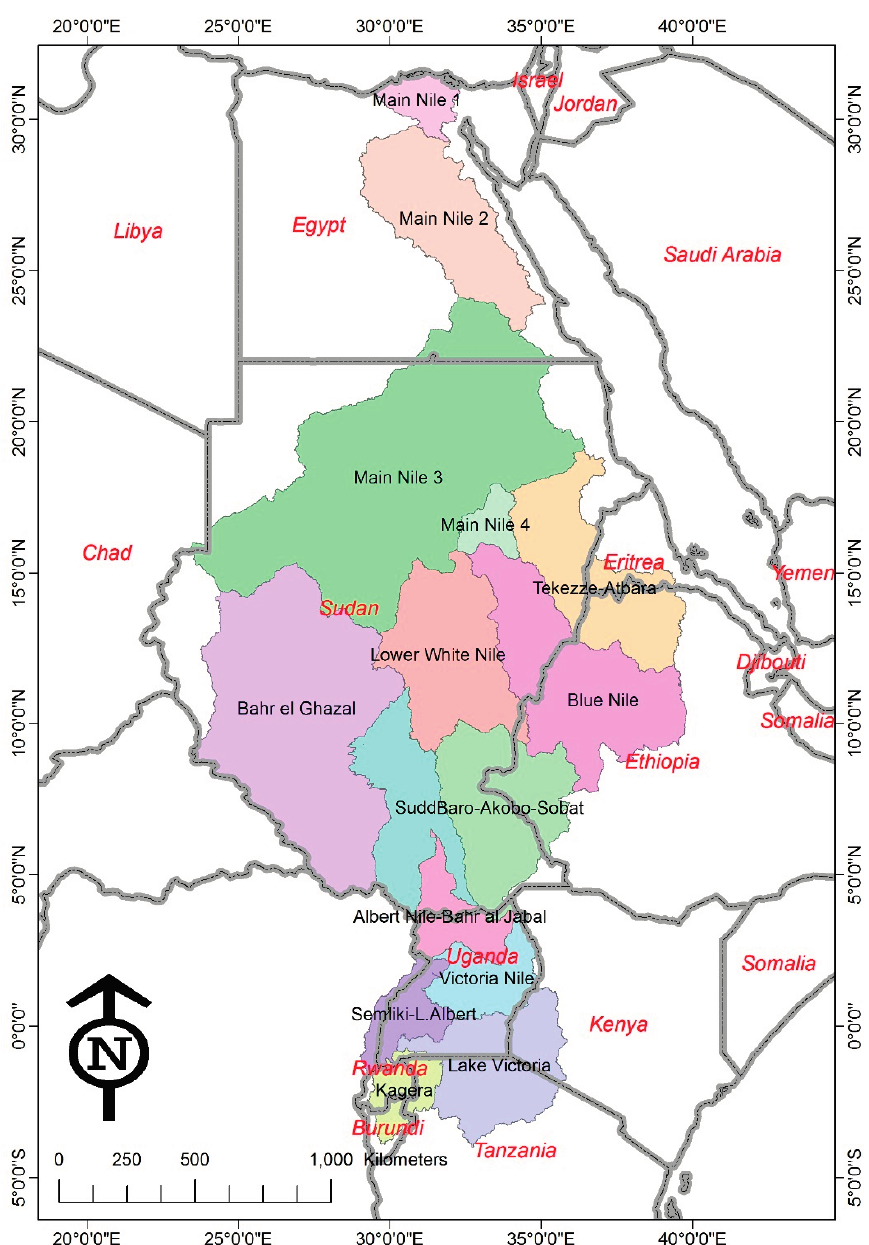
Figure 1. Location of sub-basins of the Nile River system delineated by the Nile Basin